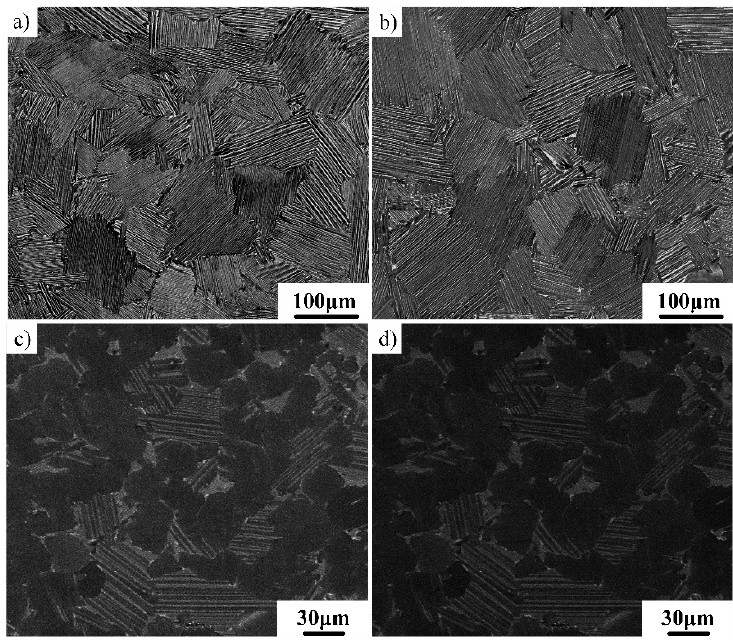
Figure 7. Quenched microstructure of TiAl alloys with di ff erent microstructures: ( a ) 700 ◦ C / FL, ( b ) 750 ◦ C / FL, ( c ) 700 ◦ C / DP, and ( d ) 750 ◦ C / DP.